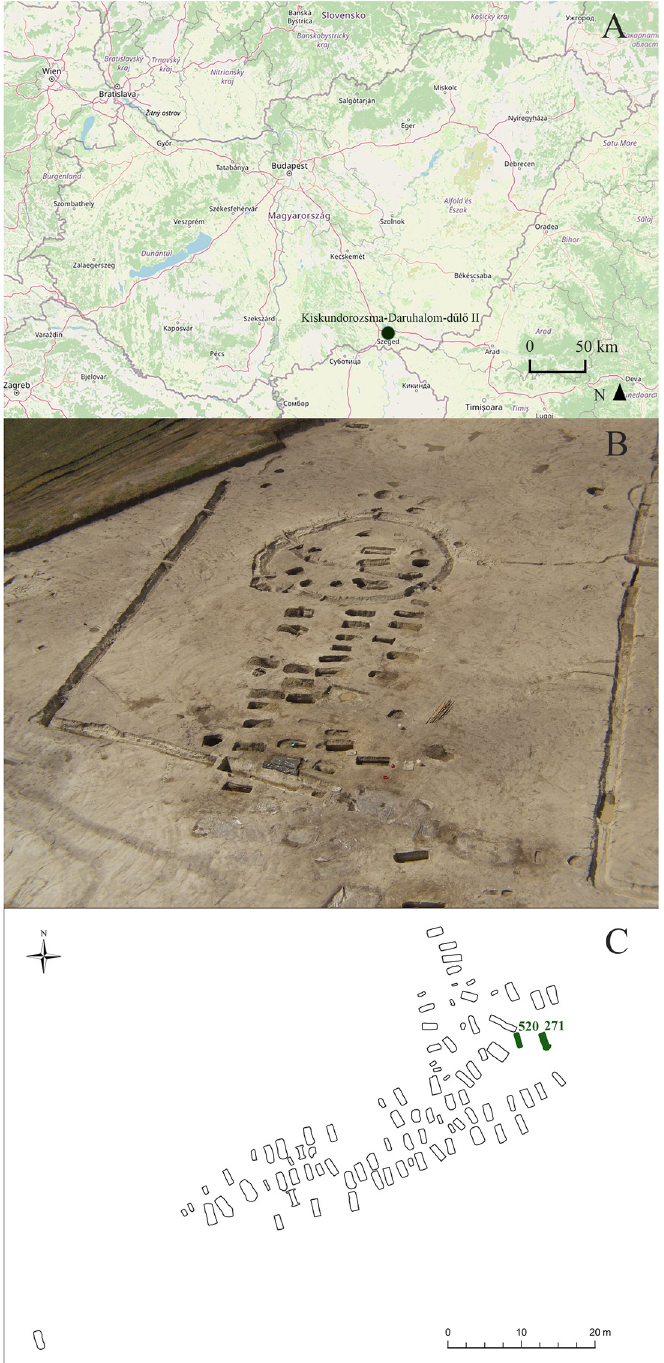
Fig 1. A) Map of Hungary showing the location of the Kiskundorozsma–Daruhalom-d ű l ő II archaeological site; B) Aerial photo of the Kiskundorozsma–Daruhalom-d ű l ő II archaeological site; and C) Plan drawing of the Avar Age cemetery of Kiskundorozsma–Daruhalom-d ű l ő II with the location of the burials of KD271 and KD520. (Contains information from OpenStreetMap and OpenStreetMap Foundation, which is made available under the Open Database